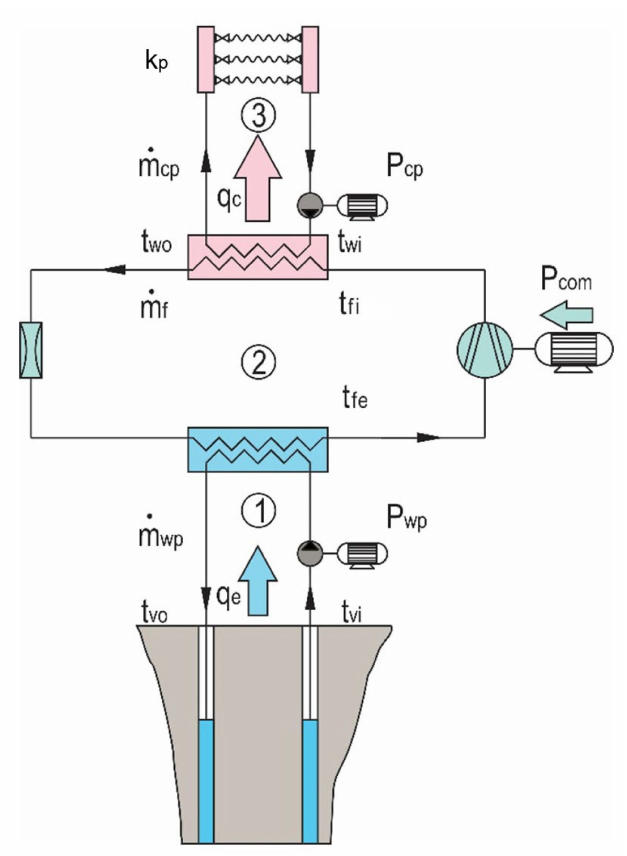
Figure 1. Heat pump heating system with heat flows, powers, and variables. 1. Cold water loop with the well pump. 2. Cooling cycle with the compressor. 3. Warm water loop with a circulation